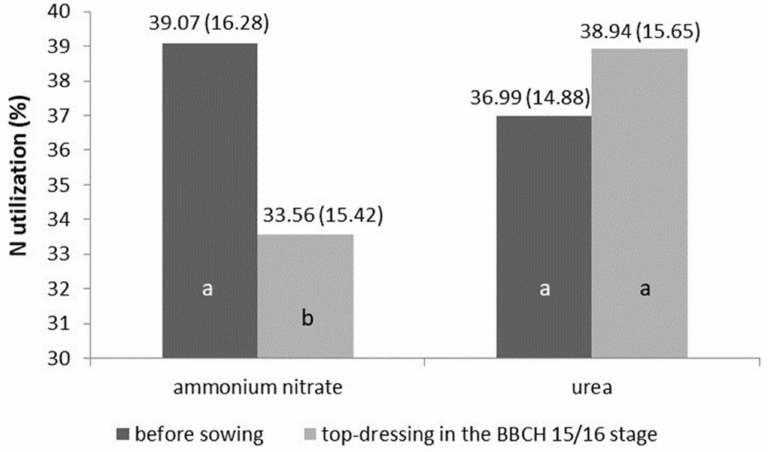
Figure 3. Mean values and standard deviations (in brackets) of N utilization (%) in successive years for the combinations of two types of nitrogen fertilizer (B) and two dates of nitrogen application (C). a, b—homogeneous groups ( α =